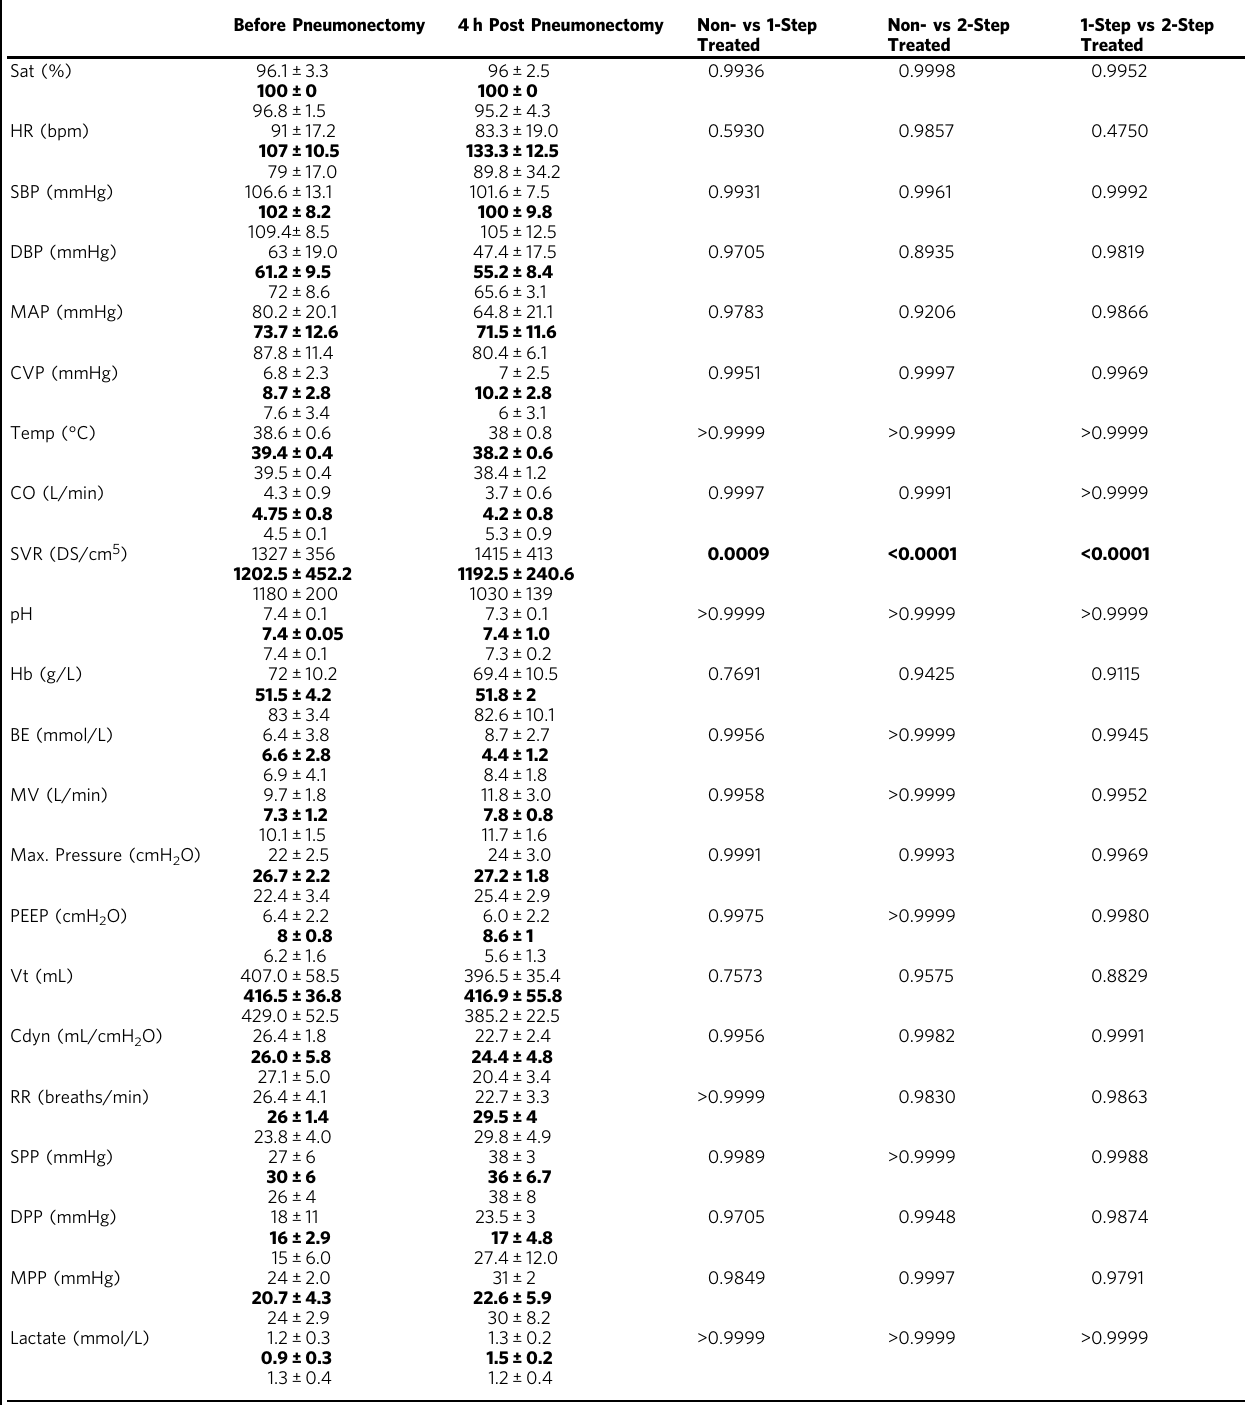
The values for the two-step treated recipients ( n = 6) are shown in the fi rst row, one-step treated recipients ( n = 4) in the second row with bold text, and the non-treated recipients ( n = 5) are in the third row for each respective parameter. Mann – Whitney and Kruskal – Wallis tests were used for statistical analysis. P values less than 0.05 are highlighted in bold text. Two-step treated: First rows (n = 6); One-step treated: Second rows, bold text ( n = 4); Non-treated: Third rows ( n = 5). Sat oxygensaturation, HR heartrate, SBP systolicbloodpressure, DBP diastolicbloodpressure, MAP meanarterialpressure, CVP centralvenouspressure, Temp temperature,Hemodynamicvariables: SPP systolic pulmonary pressure, DPP diastolic pulmonary pressure, MPP mean pulmonary pressure, CO cardiac output, SVR systemic vascular resistance, PVR pulmonary vascular resistance, Blood gas parameters: Hb hemoglobin, lactate, BE base excess, Mechanical ventilator settings with volume-controlled ventilation: MV minute volume, PIP peak inspiratory pressure, PEEP peak inspiratory pressure, positive end-expiratory pressure, Vt tidal volume, RR respiratory